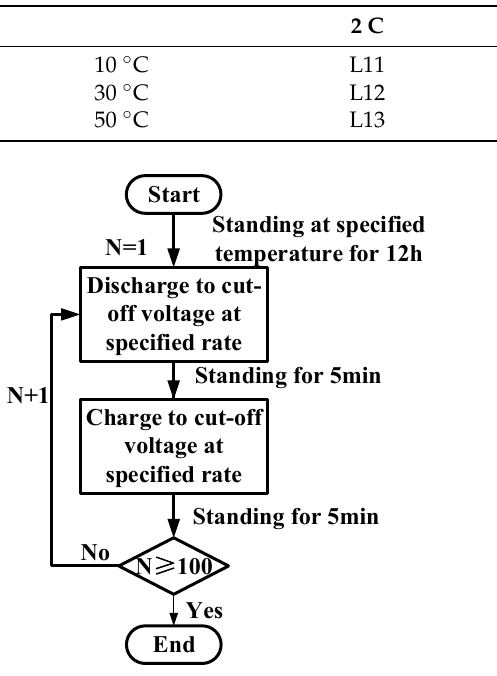
Figure 1. Flowchart of the charge–discharge cycle test with different aging paths.